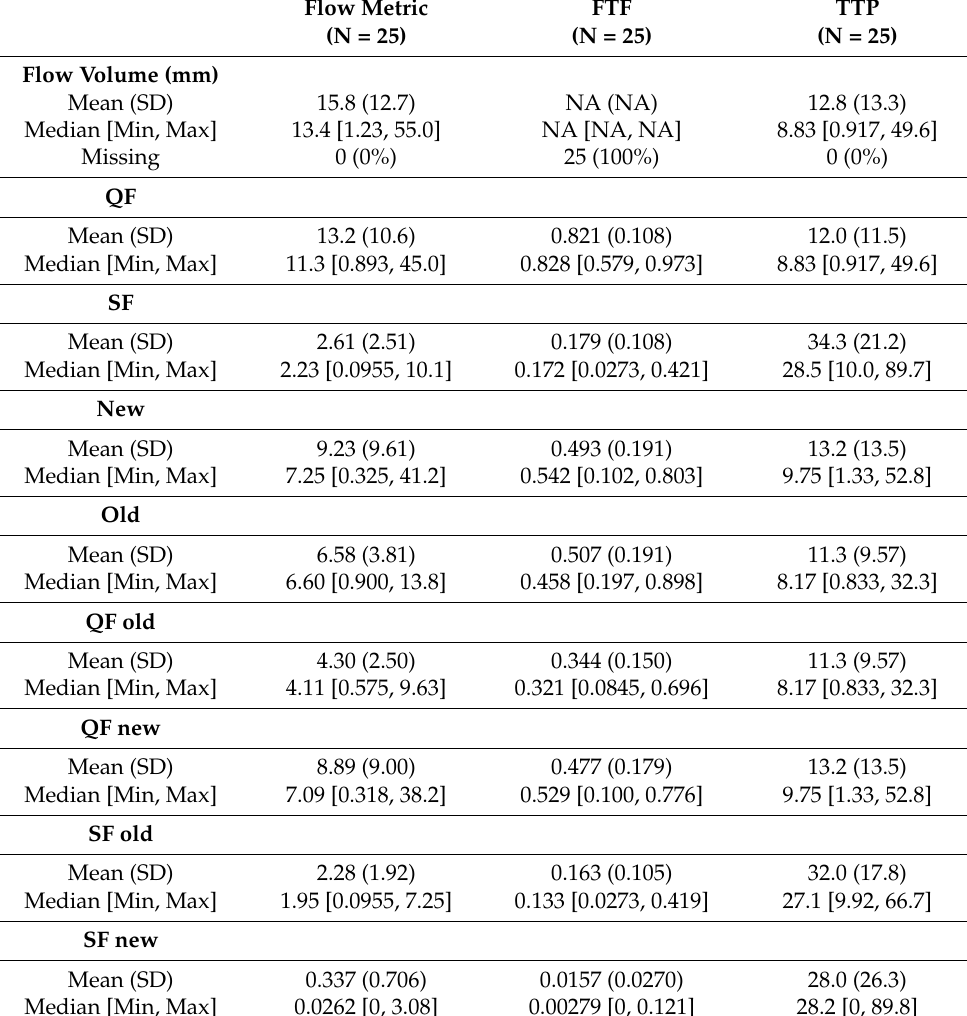
Table 3. Summary statistics for TD flow metrics, fraction of total flow (FTF), and time to peak (TTP) for total TD event flow and hydrograph separation components from the flow pathway (QF, SF), source connectivity (new, old), and four-component